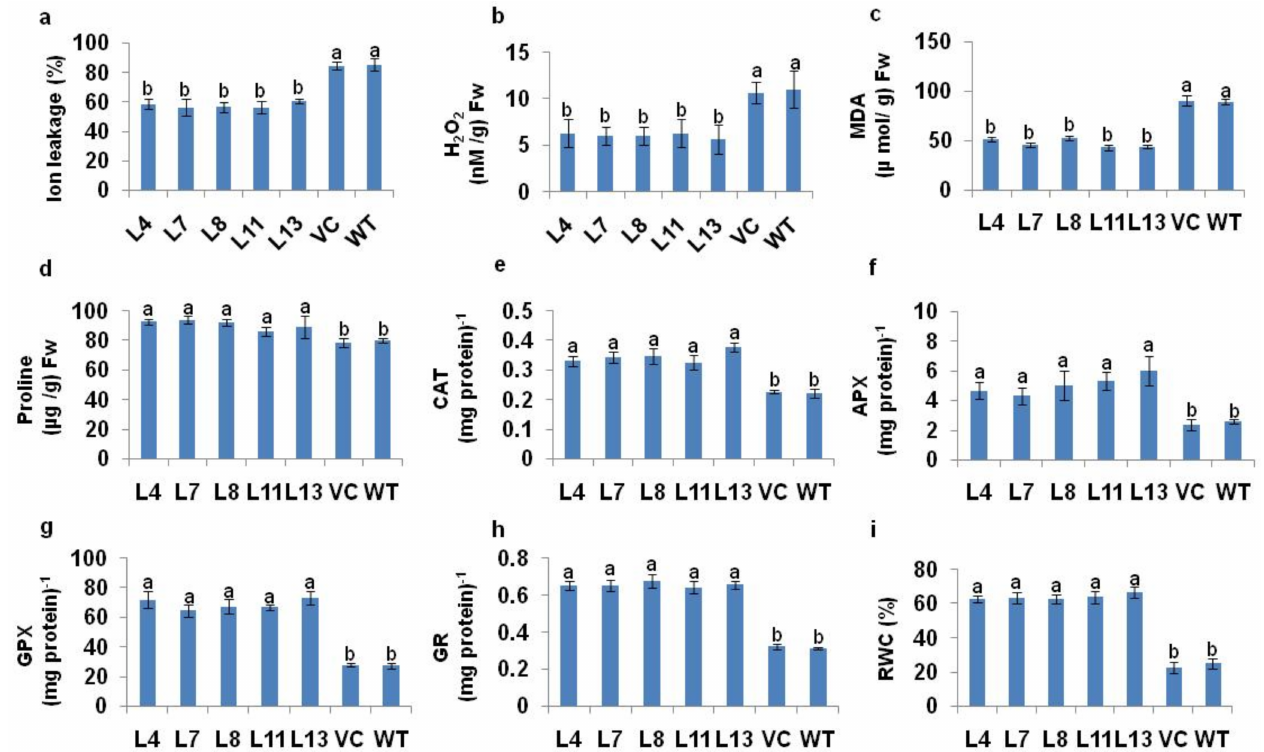
Figure 4. Biochemical analysis of PDH45 -overexpressing T 1 transgenic lines (L4, L7, L8, L11, L13, VC) and WT plants exposed to 24 h at 200 mM NaCl treatment. ( a ) Ion leakage. ( b ) Hydrogen peroxide (H 2 O 2 ) content. ( c ) Lipid peroxidation expressed in terms of MDA content. ( d ) Level of proline accumulation. ( e ) Catalase (CAT) activity; one unit of enzyme activity defined as 1 µ mol H 2 O 2 oxidized min − 1 . ( f ) Ascorbate peroxidase (APX) activity; one unit of enzyme activity defined as 1 µ mol of ascorbate oxidized min − 1 . ( g ) Guaiacol peroxidase (GPX) activity. ( h ) Glutathione reductase (GR) activity; one unit of enzyme activity is defined as 1 µ mol of GS-TNB formed min − 1 due to reduction of DTNB. ( i ) Percent relative water content (RWC). Values are mean ± SE ( n = 3). Different letters on the top of bars indicate significant differences at p ≤ 0.05 level as determined by Duncan’s multiple range test